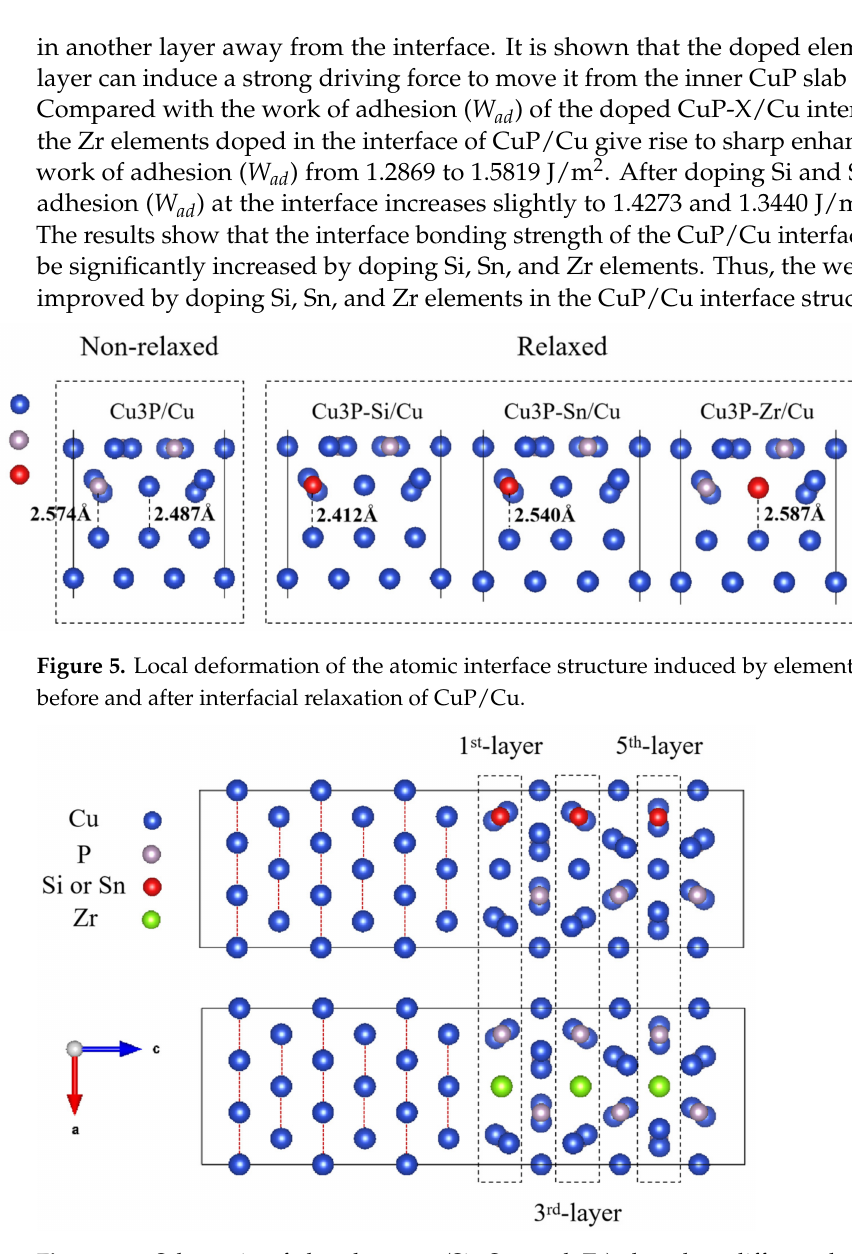
Figure 6. Schematic of the elements (Si, Sn, and Zr) doped at different layers in CuP/Cu interface structure. Table 4. The work of adhesion ( W ad ) of the relaxed CuP-X/Cu